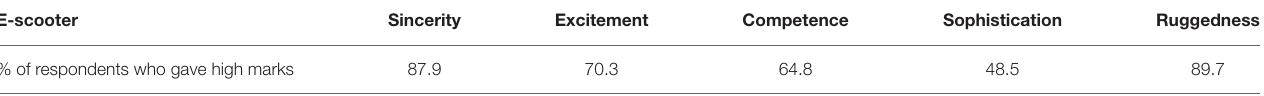
TABLE 3 | Characteristics of electric scooter personality perceived by Chinese consumers.